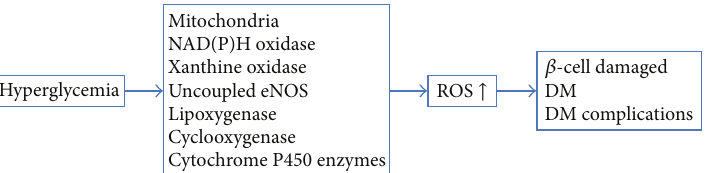
Figure 1: The mechanisms of ROS and DM development. Hyperglycemia may activate ROS generation through the mitochondrial and nonmitochondrial origins: NADPH oxidase, xanthine oxidase, uncoupled eNOS, lipoxygenase, cyclooxygenase, cytochrome P450 enzymes, and other hemoproteins. ROS can further cause 𝛽 -cell damages and the development of DM and related